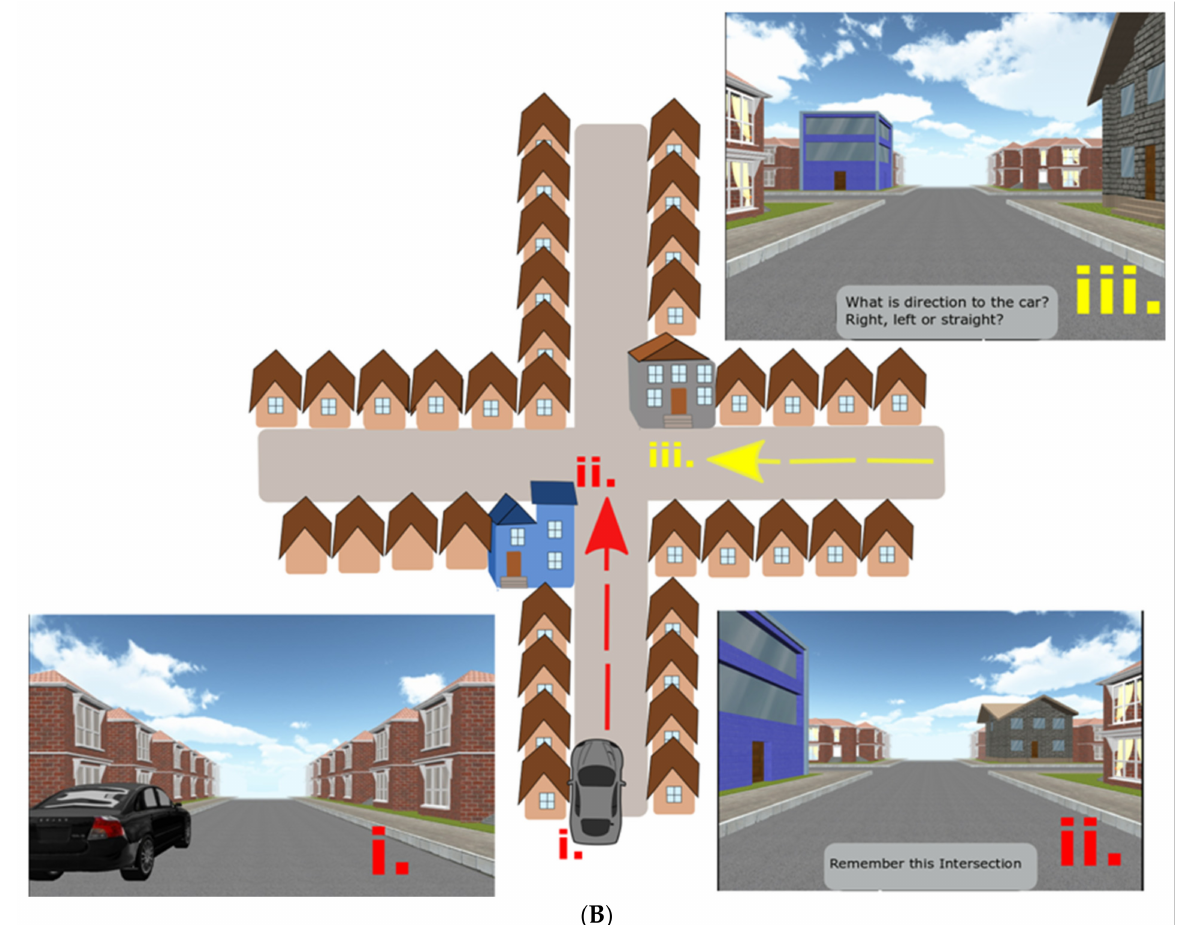
Figure 1. ( A ) The Navigation Test Suite with schematic aerial view and corresponding screenshots from the route-repetition and the route-retracing tasks. Three points on the map are labeled: (i.) The start location next to the car. (ii.) One of the intersections along the route with gray houses at the corners of the intersection. (iii.) The end of the route where the telephone box is present. In the route-repetition task, the participants were passively transported through the city from the car to the telephone box during the encoding phase and in the test phase the participants had to reproduce the same route. The route-retracing task was identical to the route-repetition task with the exception that participants in the test phase had to find their way back from the telephone box to the car. The order of intersections and houses at each intersection had a different design in each of these two tasks. ( B ) The Navigation Test Suite with schematic aerial view and corresponding screenshots from the directional-approach task: (i.) Participants started the task next to the car. (ii.) The encoding phase, where participants were passively transported towards one of the intersections featuring two unique houses. Participants had to remember where the car was parked. (iii.) The test phase, where participants approached the intersection from a different direction (here from east) and had to indicate direction to the